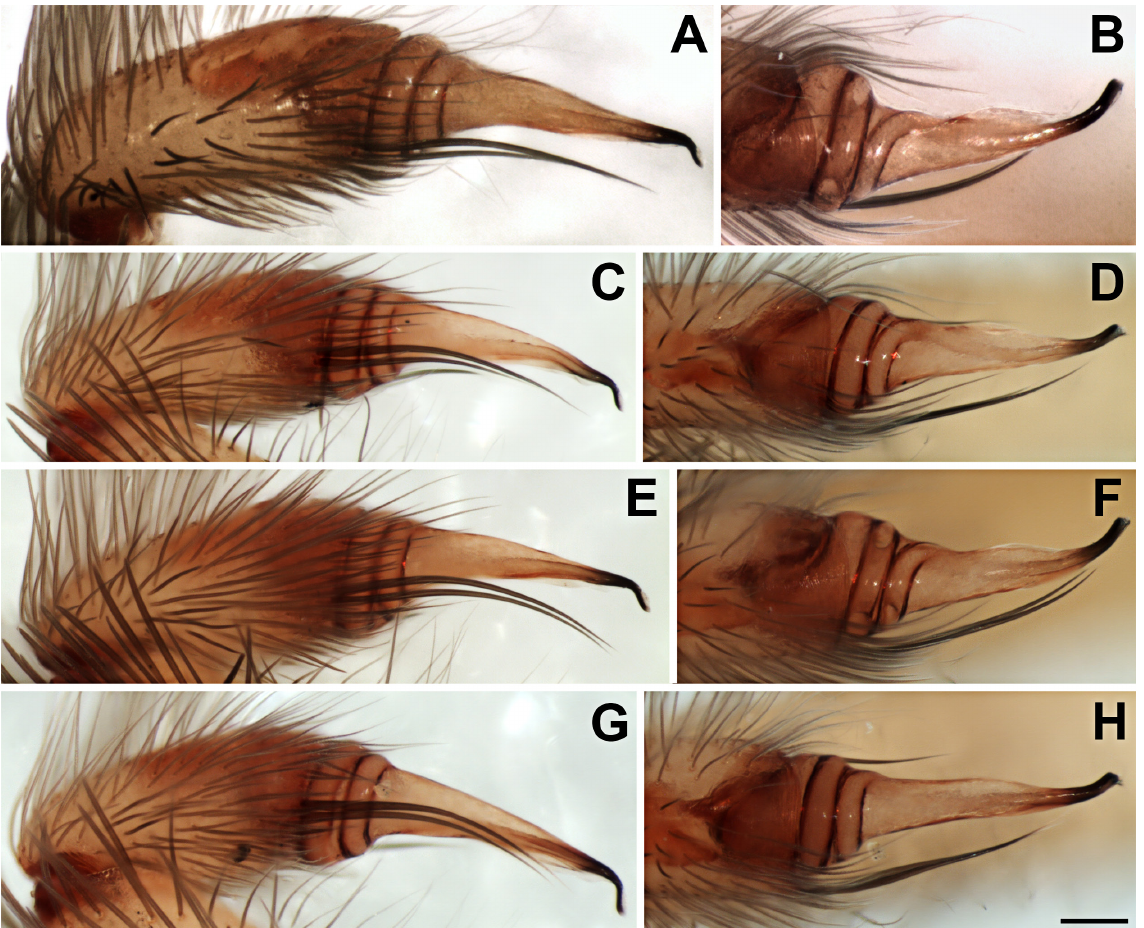
Fig. 6. Filistata insidiatrix (Forsskål, 1775), left bulb, prolateral (A, C, E, G) and dorsal (B, D, F, H) views. A–B . France (MACN-Ar 39461, ♂ collected with ♀ IFM-1702). C–D . Spain (CRBA IFM- 2196). E–F . Israel, Ornit cave (MACN-Ar 41813, IFM-2175). G–H . Israel, Sharakh cave (MACN-Ar 41218, IFM-2144). Scale bar = 0.1 mm, all figures